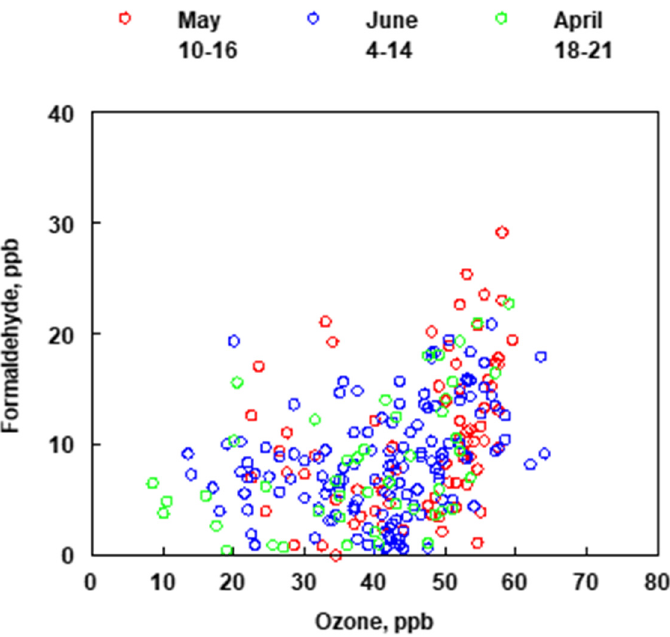
Figure 9. Comparison of the concentrations of ozone and formaldehyde for months of April, May and June (2019).